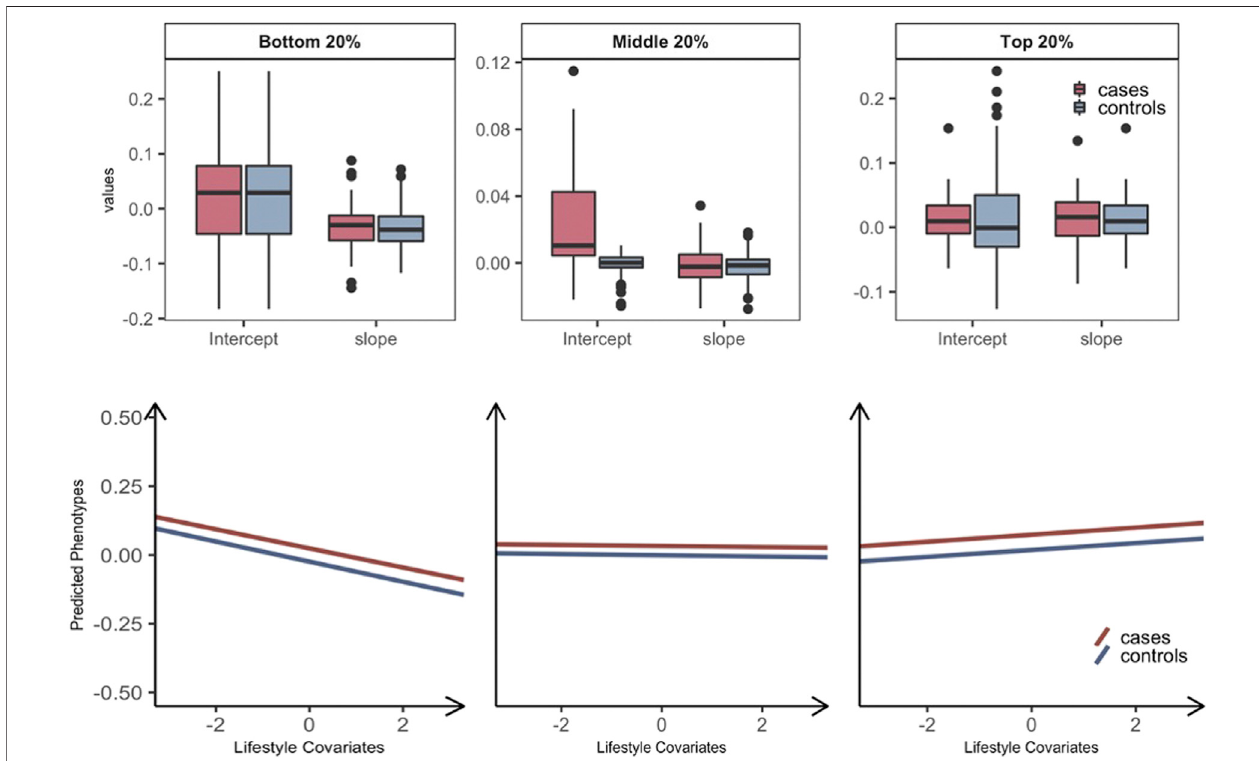
FIGURE 2 | Plasticity of diabetes-related metabolic traits of 69 signi fi cant overall interactions in response to the level of lifestyle effects by grouping T2DM prospective cases and controls. Individuals are strati fi ed into three groups: the bottom, middle, and top 20% groups according to estimated GxE and RxE interactions + σ 2 fi ed individuals into T2DM prospective cases (red) and controls (blue) in each of three groups, hence, six groups in from the full model (i.e., σ 2 α τ 1 ). We further classi 1 total. To compare the differences in trajectories between with T2DM cases and controls, a linear model regressing the phenotype of main trait on standardized lifestyle measures was used to estimate the intercept and slope for each of six groups. The values of intercepts and slopes were averaged over the 69 analyses that showedsigni fi cantsignalsforbothGxEandRxEinteractions.Theaveragedvaluesofinterceptsandslopesrepresenttheoverallrelationshipbetweenmetabolicriskand lifestylecovariates,whereweconsideredmakingfavorableandunfavorabledirectionsconsistentacrossthemaintraitandcovariatestofacilitateabetterinterpretationin linewith metabolic risks on T2DM (see Methods ). Boxplots for each group are represented to show the differences in terms of the calculated intercepts and slopes, and the mean of values for intercepts and slopes were represented as regression lines. The mean and standard error of intercepts and slopes across the analyses of the 69 pairswithsigni fi cantoverallinteractionswereestimatedtoassessifthereisanysigni fi cantdifferenceofthemeanbetweencasesandcontrolineach ofthethreegroups: the bottom, middle, and top 20% groups. There were no signi fi cant differences between cases and controls in the mean of slopes in all three groups. The mean of intercepts is signi fi cantly different between cases and controls in all three groups ( p -values = 2.25E-07, 6.98E-10, and 1.68E-09). The arrows on both axes in linear regression fi gures indicate an unfavorable direction in regard to T2DM health.